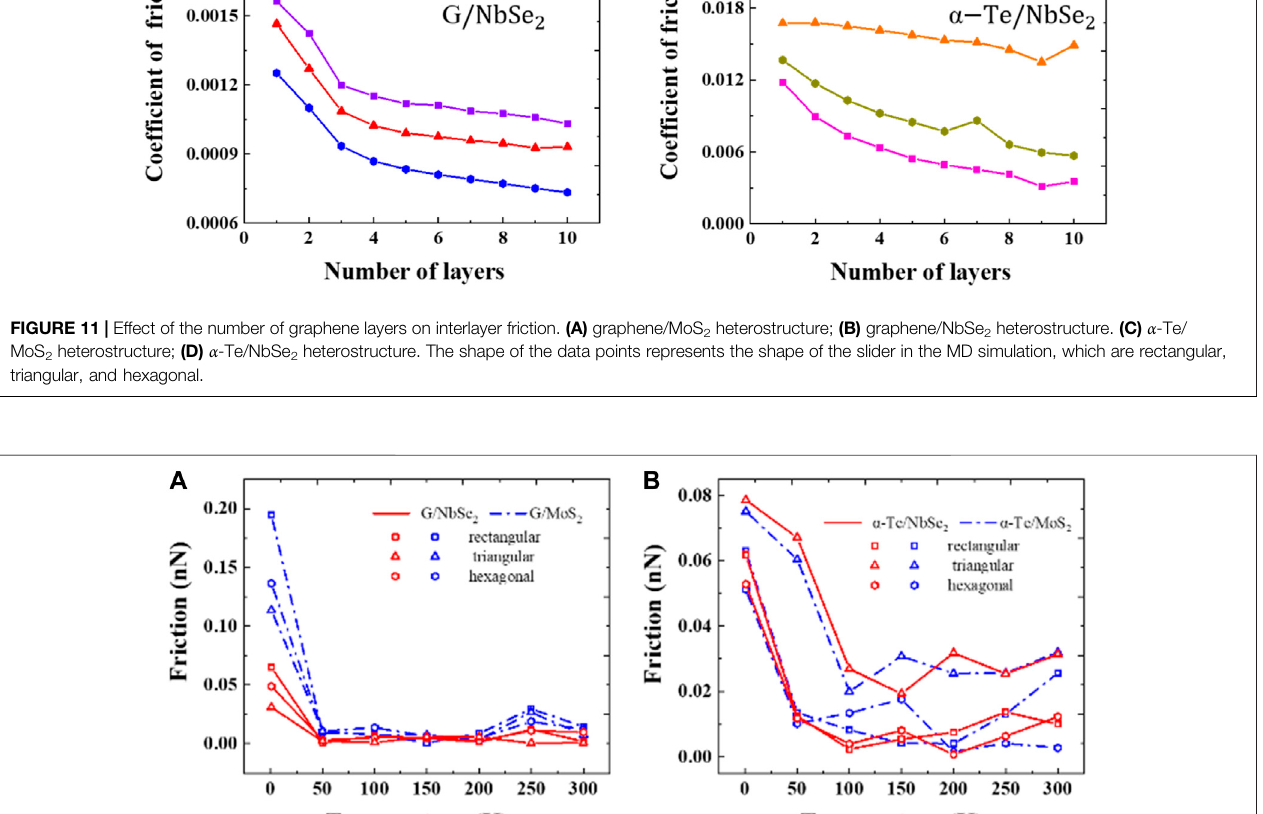
Frontiers in Mechanical Engineering |